Question: Write the caption for this figure.
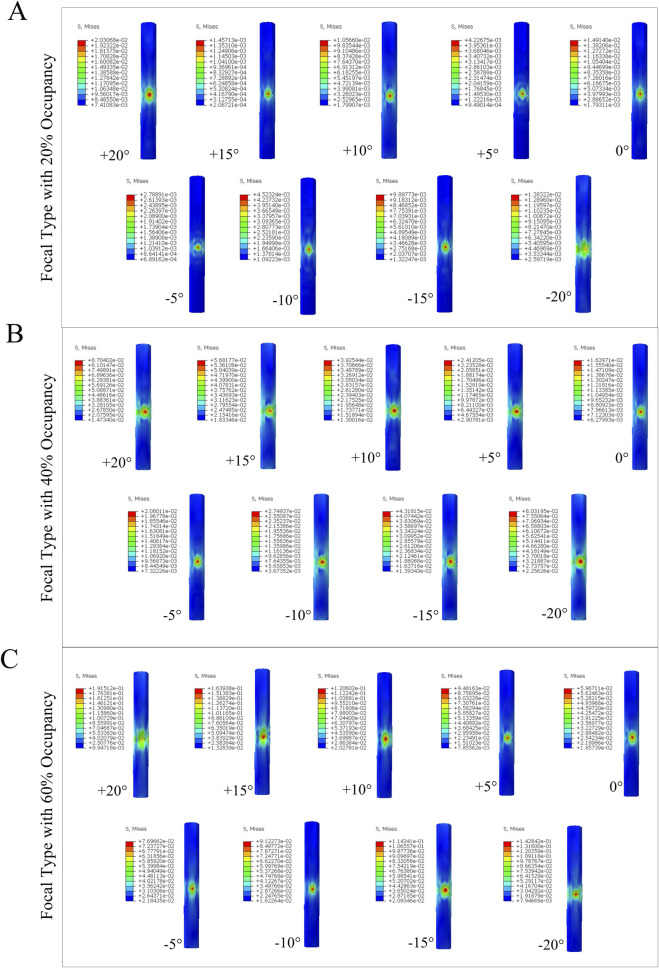
Answer: Von Mises stress distribution contours in the spinal dura mater under different spinal canal occupancy rates and flexion-extension angles for segmental C-OPLL. (A) Occupancy rate 20%; (B) Occupancy rate 40%; (C) Occupancy rate 60%. Angles in sequence: extension 20°, 15°, 10°, 5°, neutral 0°, flexion 5°, 10°, 15°, 20°. Stress scale unit: MPa.